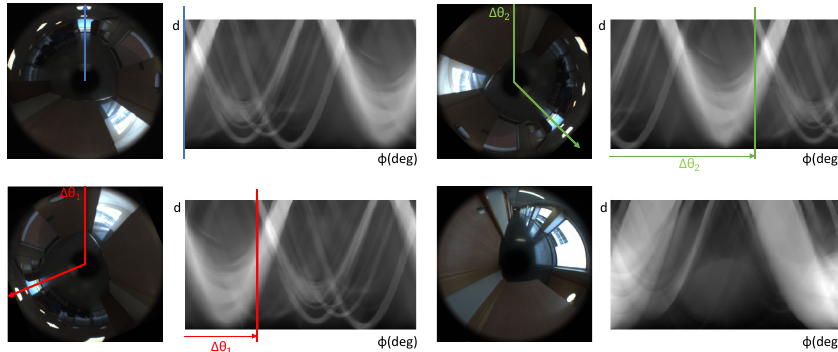
Figure 1. Shift property in the Radon